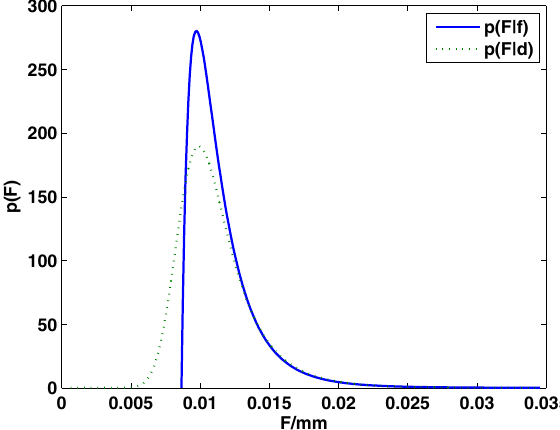
Fig. 2. Posterior densities p ( F | f ) and p ( F | d ) derived ac- cording to models (9), and (12)–(13), respectively, for eight observations generated at random with F = 0 . 0100 mm, A = 0 . 0000 mm and σ M = 0 . 002 mm.